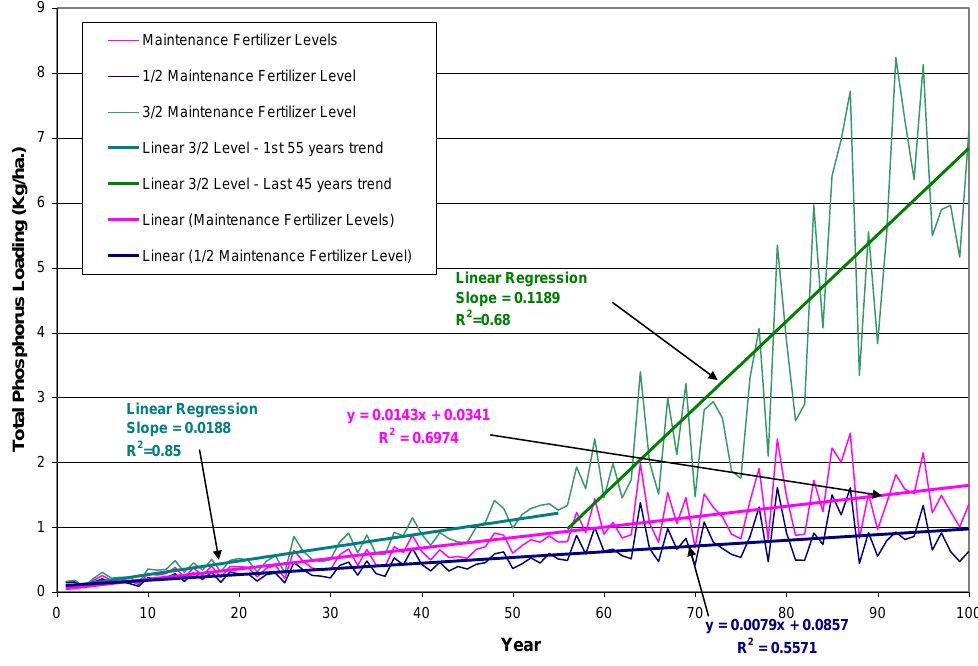
Figure 4. Annual phosphorus loading at the Upper Auglaize Watershed Outlet from Different Initial Soil P levels for the existing P application